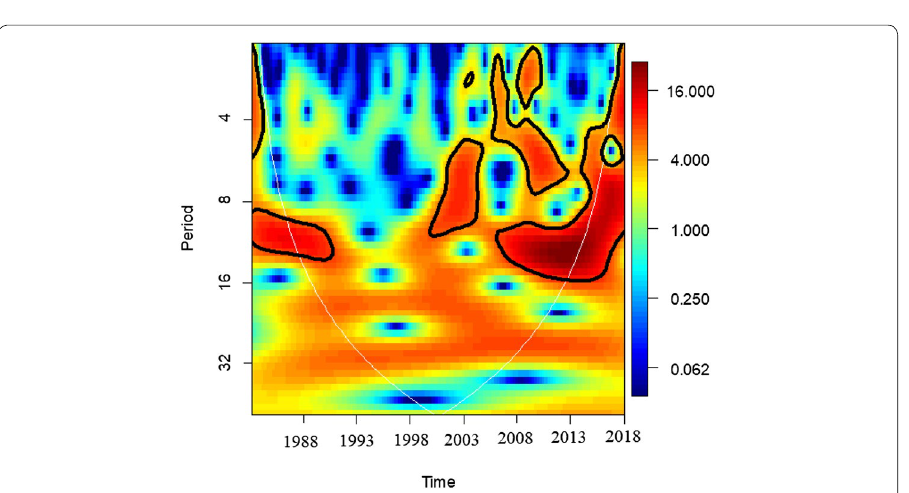
Fig. 3 Wavelet power spectrum for